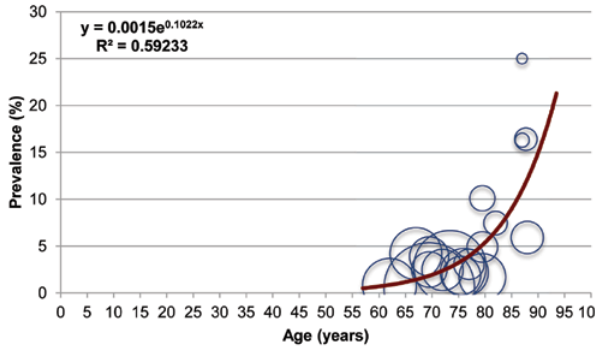
size of each bubble.